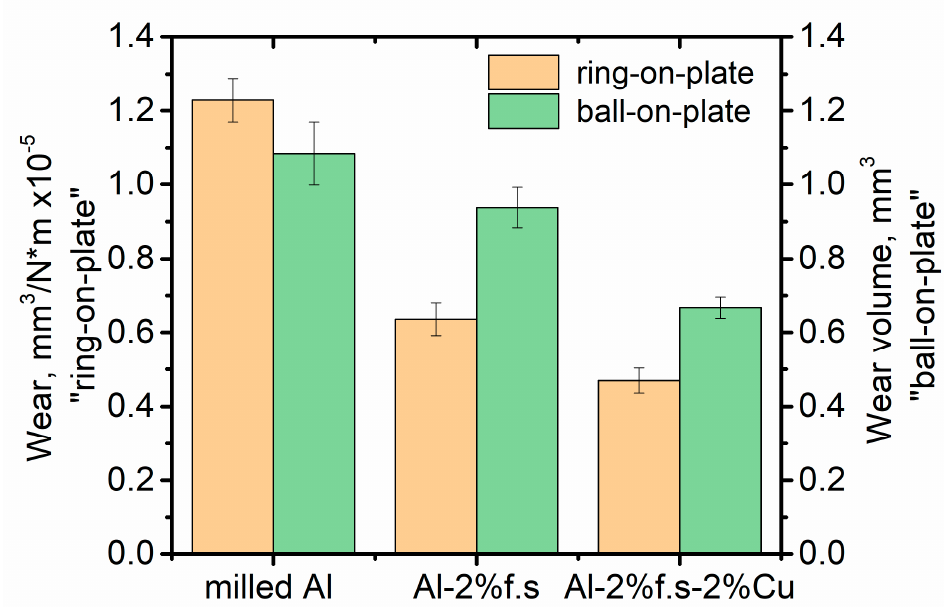
Figure 8. Wear of the samples, measured for the “ring-on-plate” and “ball-on-plate” schemes. Wear volume for “ball-on-plate” scheme was measured for 15 min of the experiment.